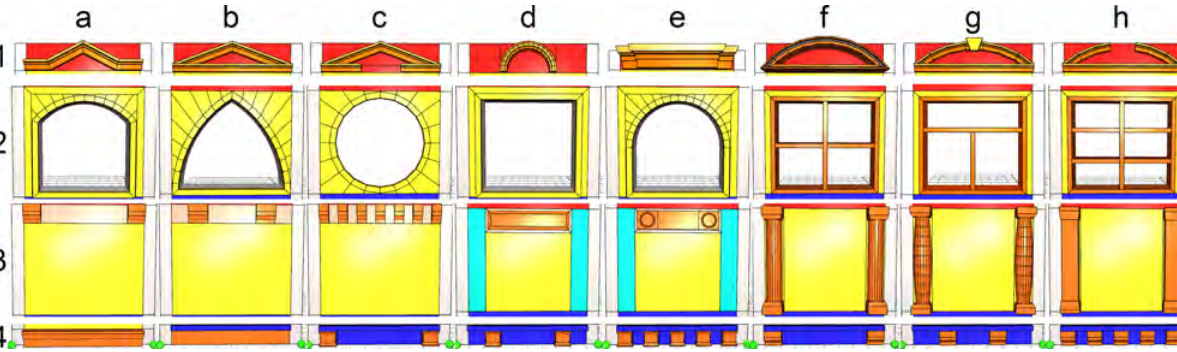
Figure 5: Samples of procedural assets from the window part library: Cornices and pediments (first row, a1-h1), window shapes with borders and crossbars (second row, a2-h2), friezes, panels and pilaster (third row, a3-h3), and window sill and decorations (bottom row, a4-h4). All these assets adapt their size to the space they are inserted to.